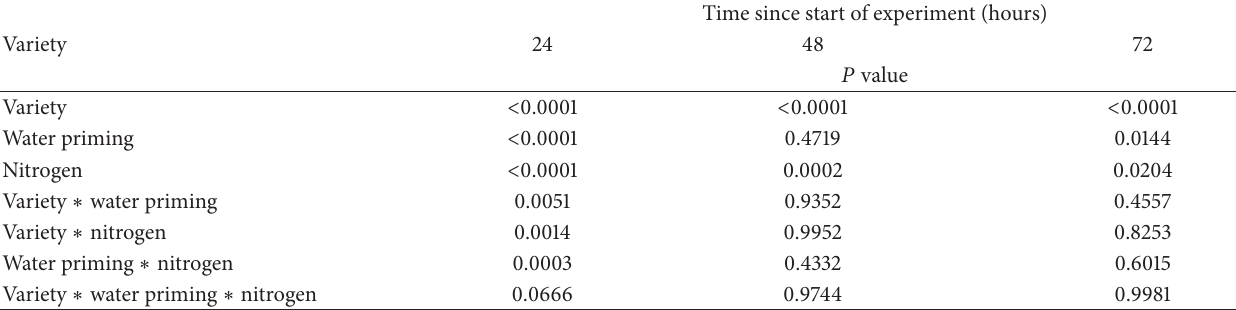
Table 1: Table showing the 𝑃 values for main variable and their interactions in laboratory